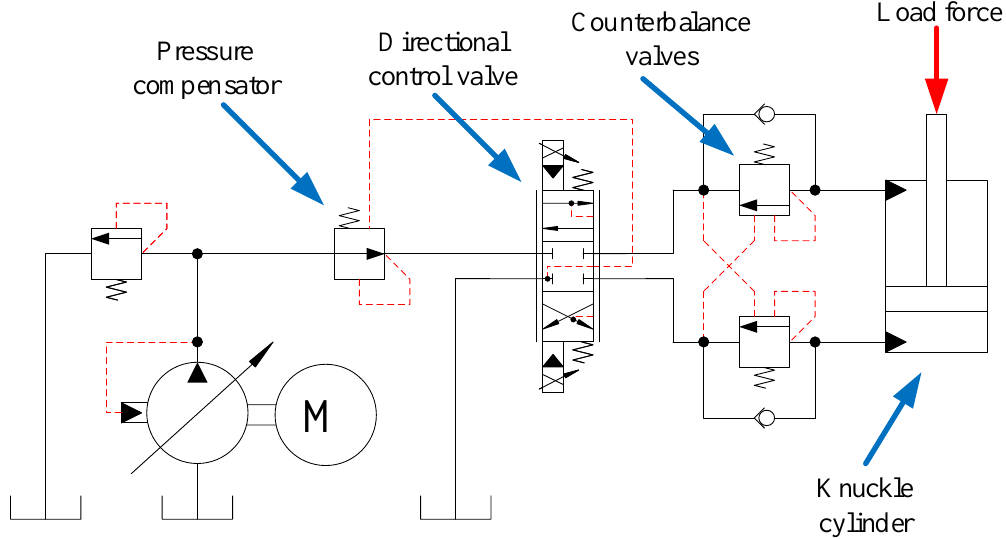
Figure 8. Hydraulic system for the knuckle cylinder.